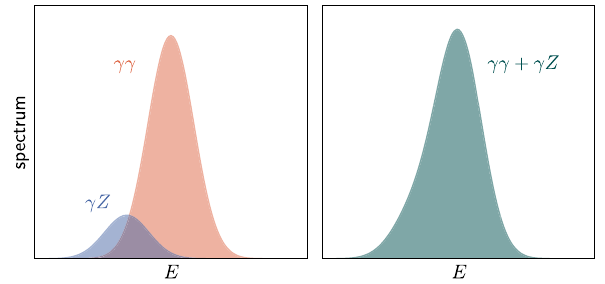
Fig. 11 Graphical example of the merging algorithm: on the left the γγ and γ Z peaks are shown separately, while on the right the obtained merged peak is